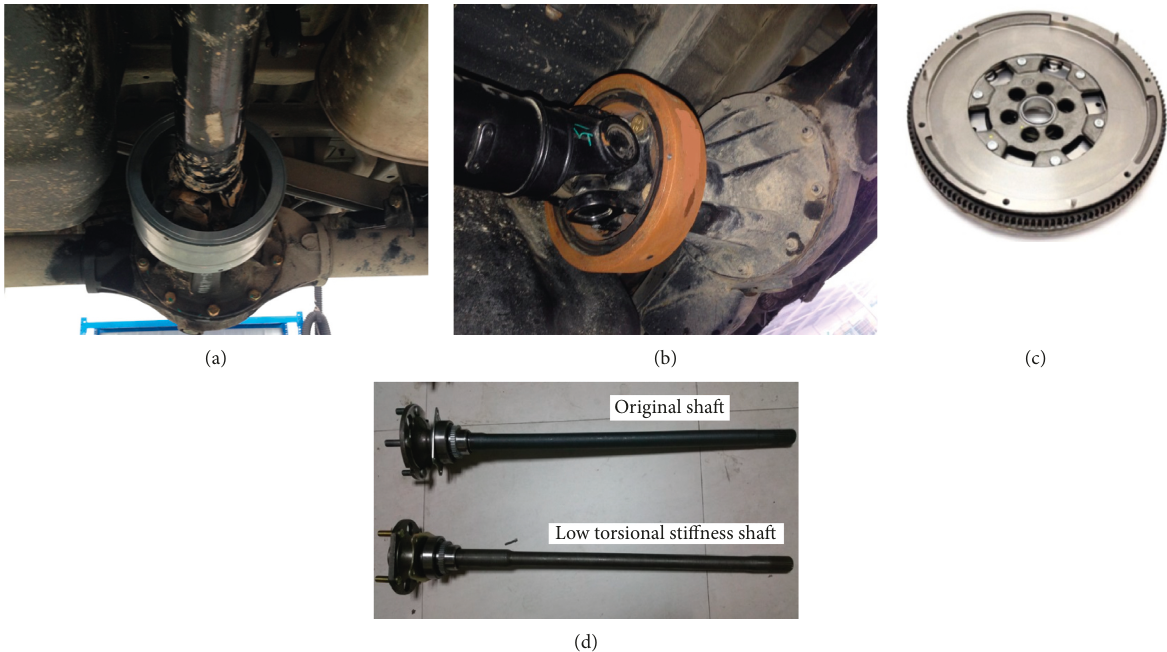
Figure 29: Drivetrain torsional vibration reductions. (a) Inertia disc. (b) Torsional vibration damper. (c) Dual mass flywheel. (d) Drive shaft